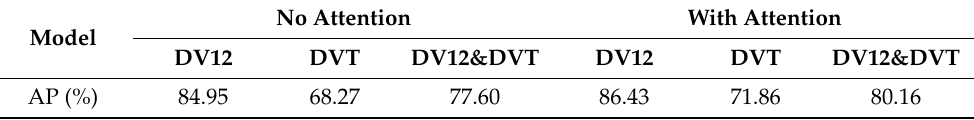
Table 7. Influence of attention mechanism in context-priming module on detection results.